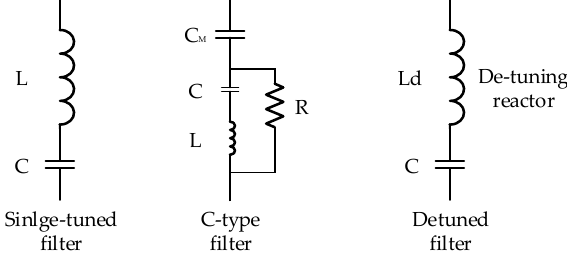
Figure 1. The most widespread passive filter banks in power utilities.